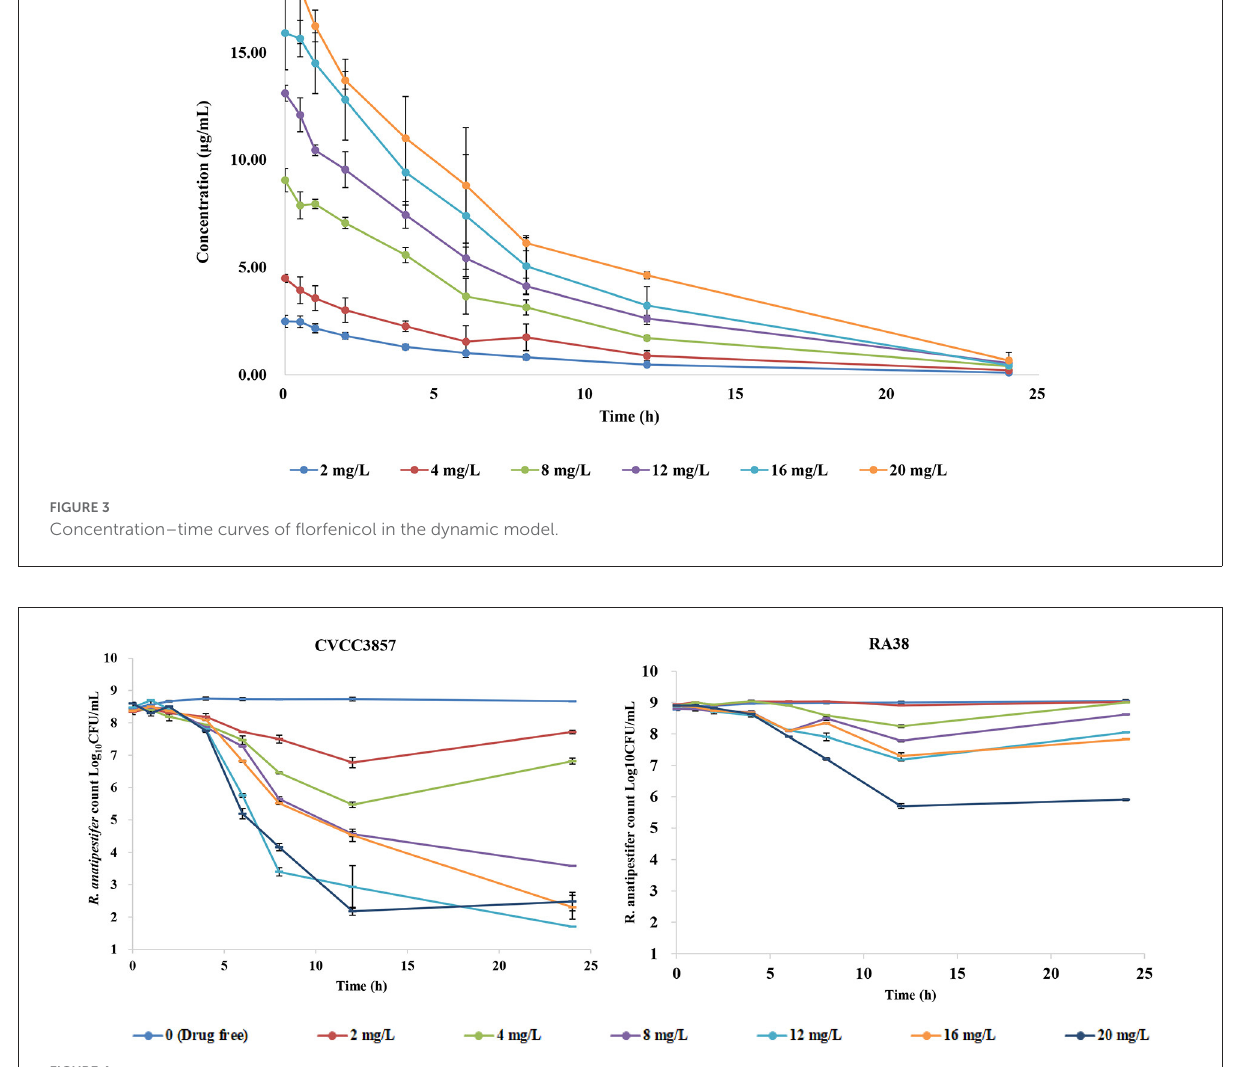
FIGURE4 Dynamic time–kill curves of florfenicol alone against R. anatipestifer